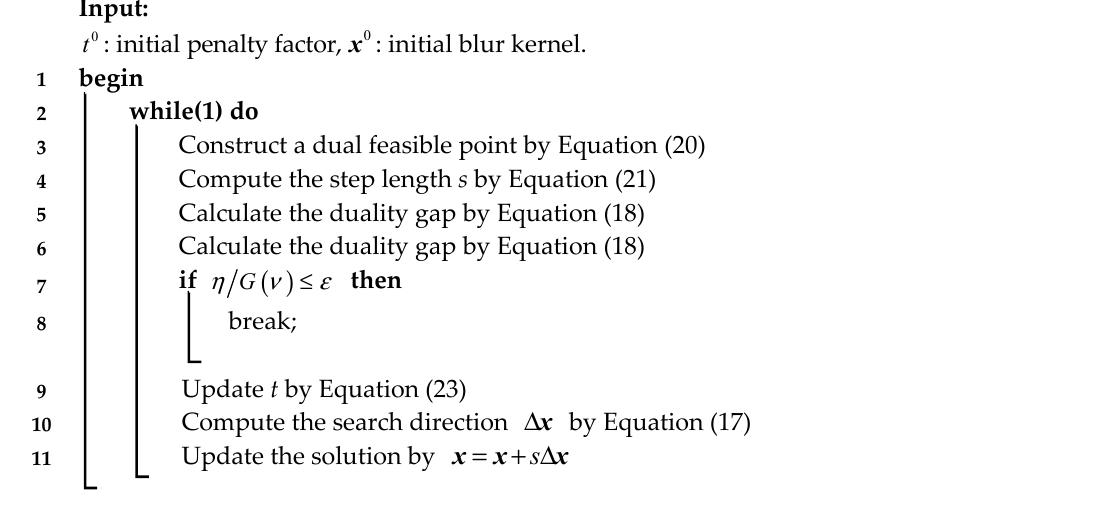
Algorithm 2: preconditioned conjugate gradient interior point algorithm